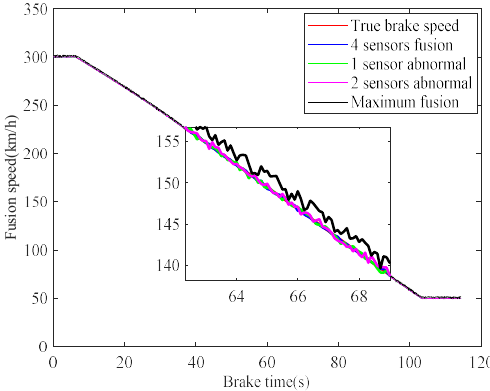
Figure 11. Fusion of speed sensors.